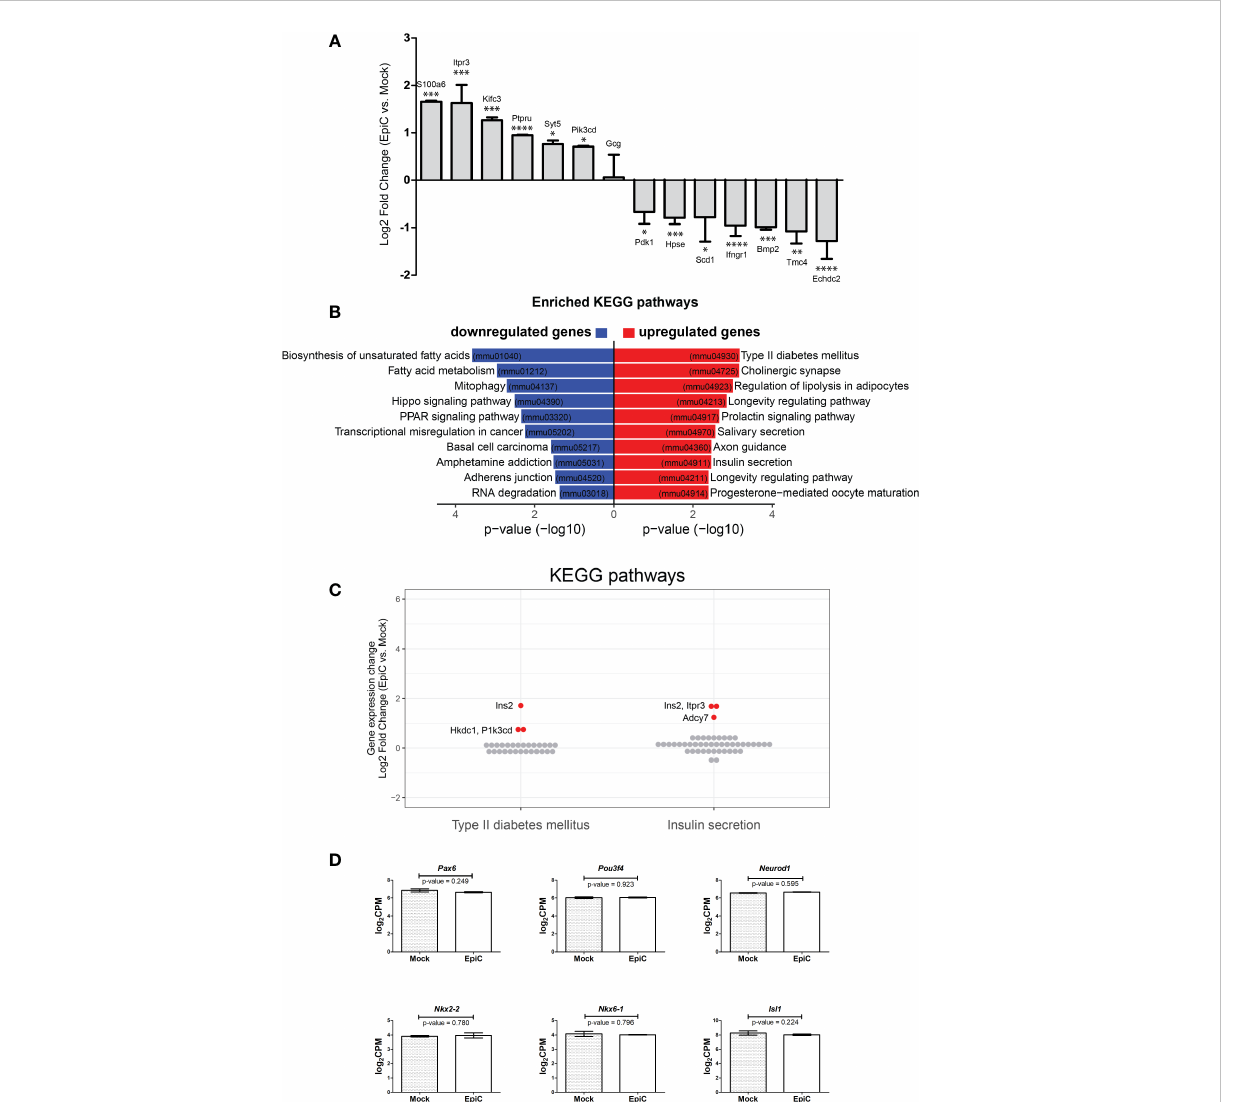
FIGURE 7 The list of biological processes associated with genes differentially expressed in EpiC vs. Mock transfected cells on the 5 th post-transfection day. (A) Up- and down-regulated gene in EpiC transfected cells versus Mock displaying log 2 fold change and p-value: *p ≤ 0.05, **p ≤ 0.01, ***p ≤ 0.001, ****p ≤ 0.0001. (B) KEGG pathway analysis. (C) Gene expression changes (log 2 fold change) of all expressed genes involved in Type II diabetes mellitus and Insulin secretion pathways. Signi fi cantly differentially expressed genes are highlighted in red (see Figure 6C). (D) Box plot displays expression differences for Pax6, Pou3f4, Neurod-1, Nkx2-2, Nkx6-1 and Isl1 using RNA-seq data. Two-sided tests were